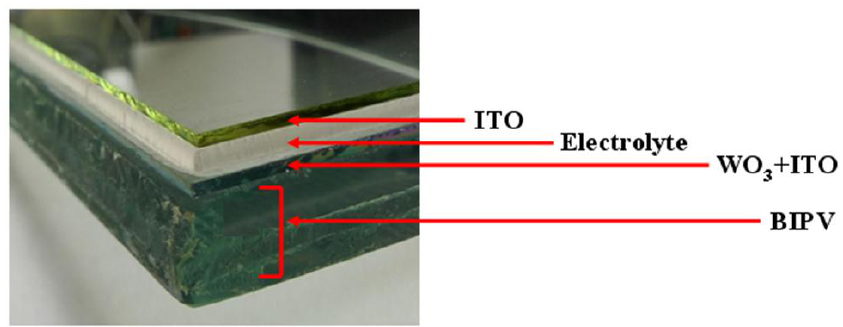
Figure 3. Photograph showing cross-section of smart